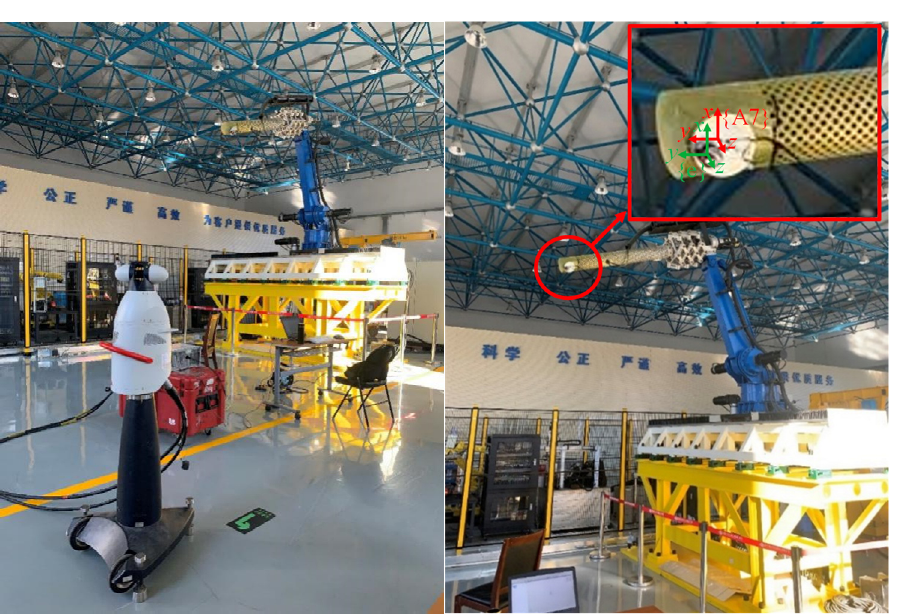
Figure 9. Calibration test using a Leica laser tracker.